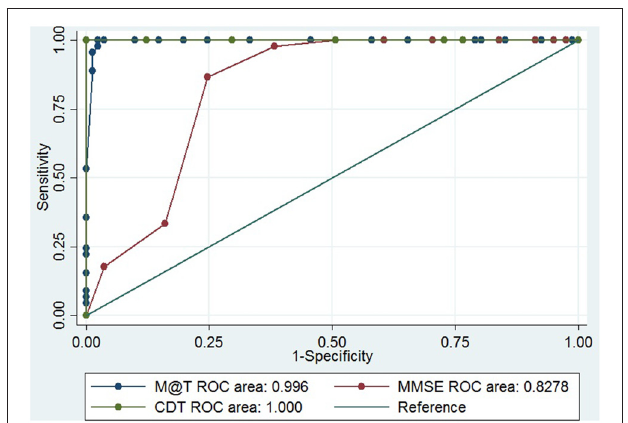
FIGURE 3 | ROC curve of M@T, MMSE and CDT to discriminate between patients with aMCI and early AD in 126 low-level education individuals from Lima-Peru. MMSE, Mini Mental State of Examination; CDT, Clock Drawing Test—Mano’s version; M@T, Memory Alteration